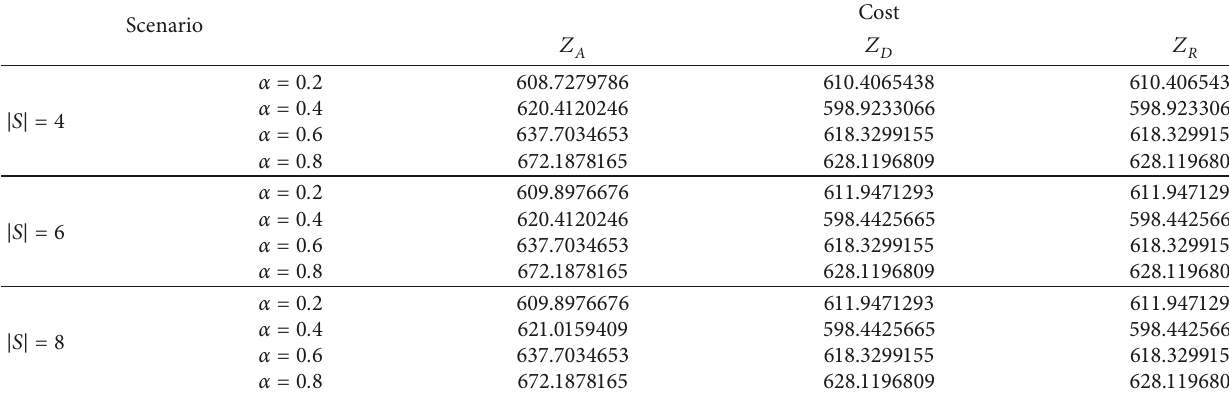
Table 7: The solution of RVRPSTW for R101.